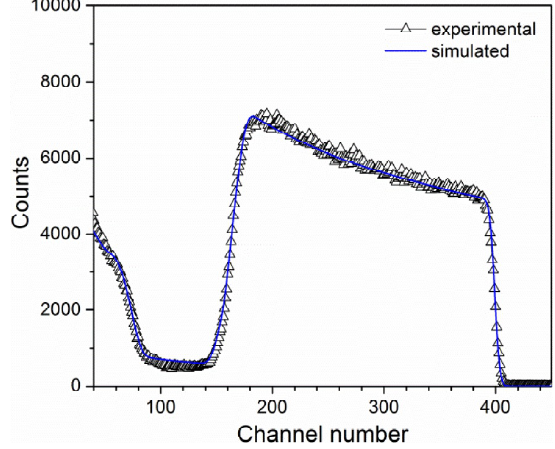
Fig. 6. Experimental RBS spectrum for sample C and corresponding simulated curve used for the calculation of atomic concentration of elements as a function of depth.